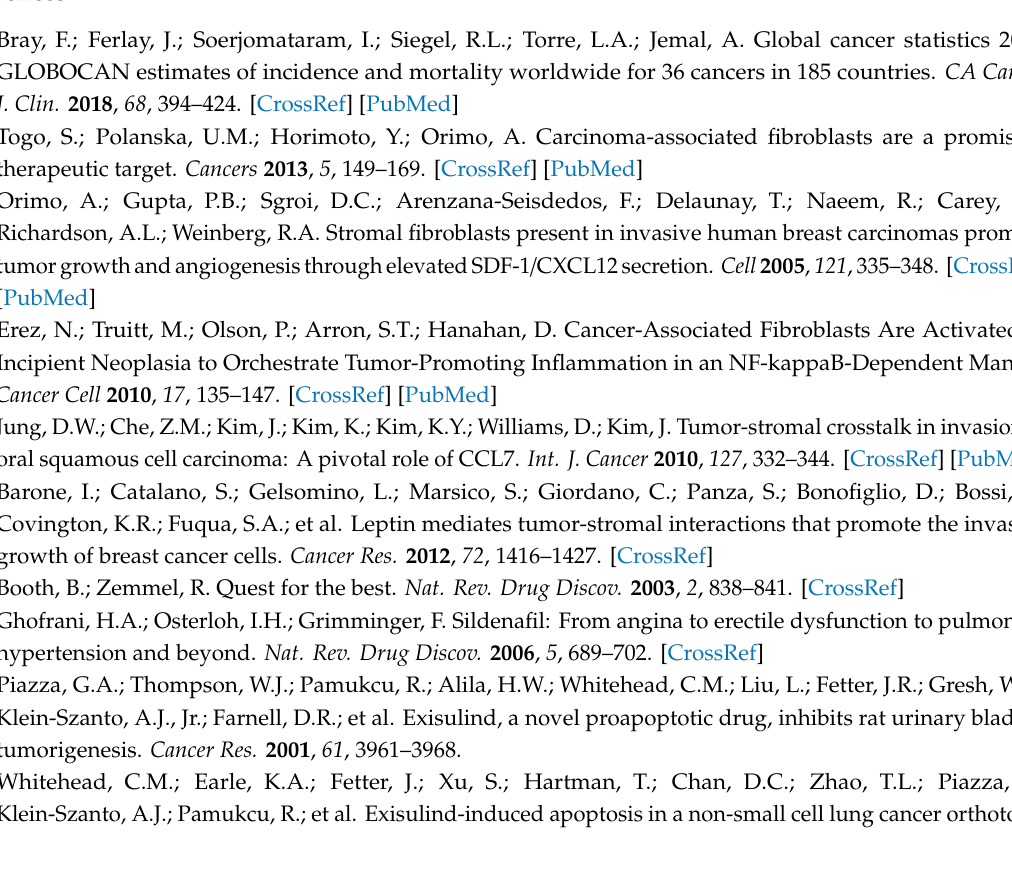
Figure S1: Characterization of human CAFs; Figure S2: Fibroblasts activation after PDE5 overexpression in stable pools; Figure S3: Uncropped Western blots from primary figures are shown; Table S1: Primers used in this